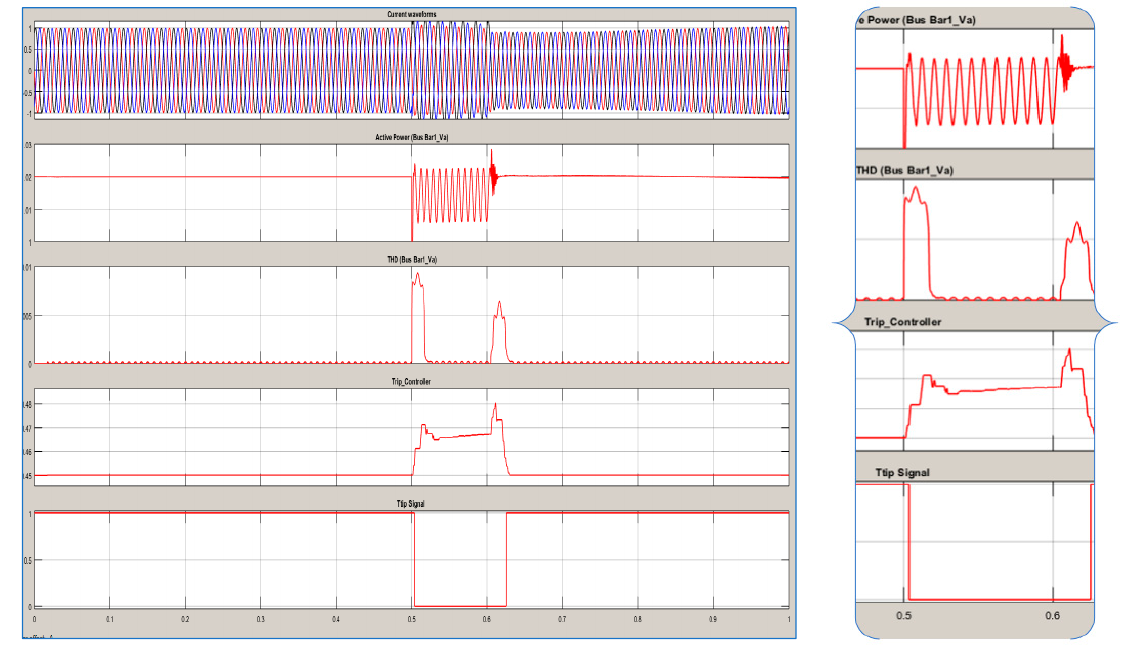
Figure 18. Double line (BC_G) fault current waveform.